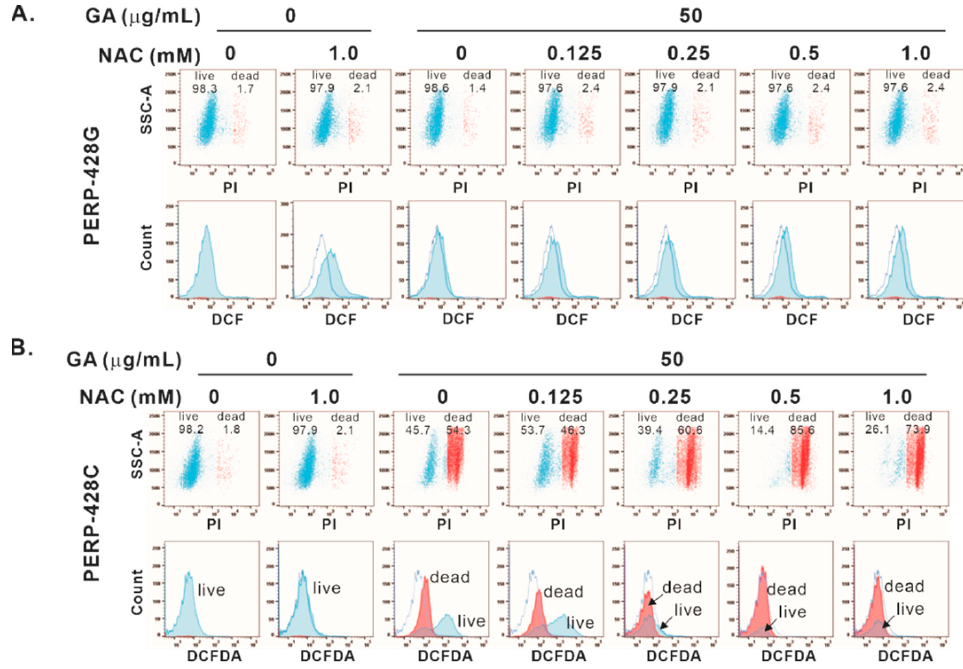
levels (Figure 6B,C), suggesting that the loss of ROS precedes the loss of membrane integ- rity during cell death .